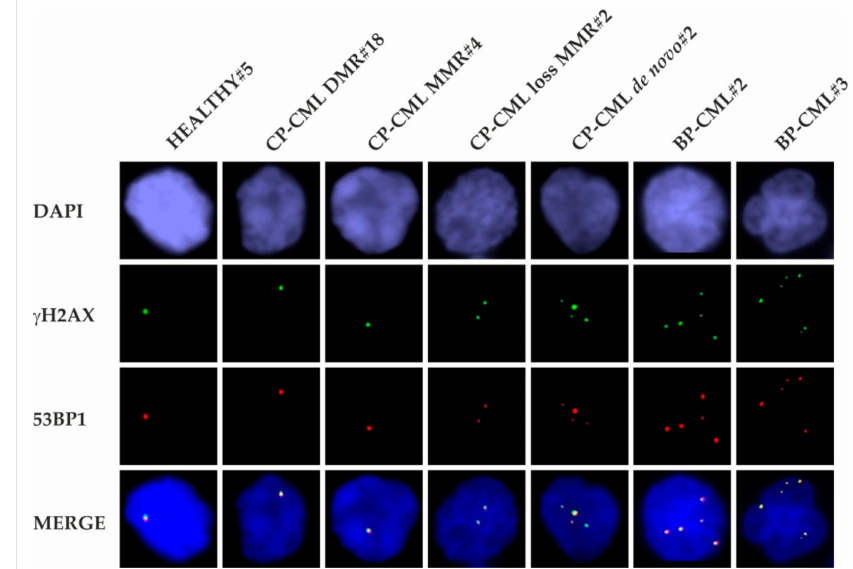
Figure 2. γ H2AX and 53BP1 foci in PBMCs of healthy donors and CML patients. Representative recordings show co-localization of γ H2AX foci (green, Alexa 488) and 53BP1 foci (red, Cy3) in PBMC nuclei (blue, DAPI) of a healthy donor (HEALTHY#5), a CP-CML patient with DMR (CP-CML DMR#18), a CP-CML patient with MMR (CP-CML MMR#4), a CP-CML patient with loss of MMR (CP-CML loss MMR#2), a de novo untreated CP-CML patient (CP-CML de novo#2), and two BP-CML patients (BP-CML#2 and